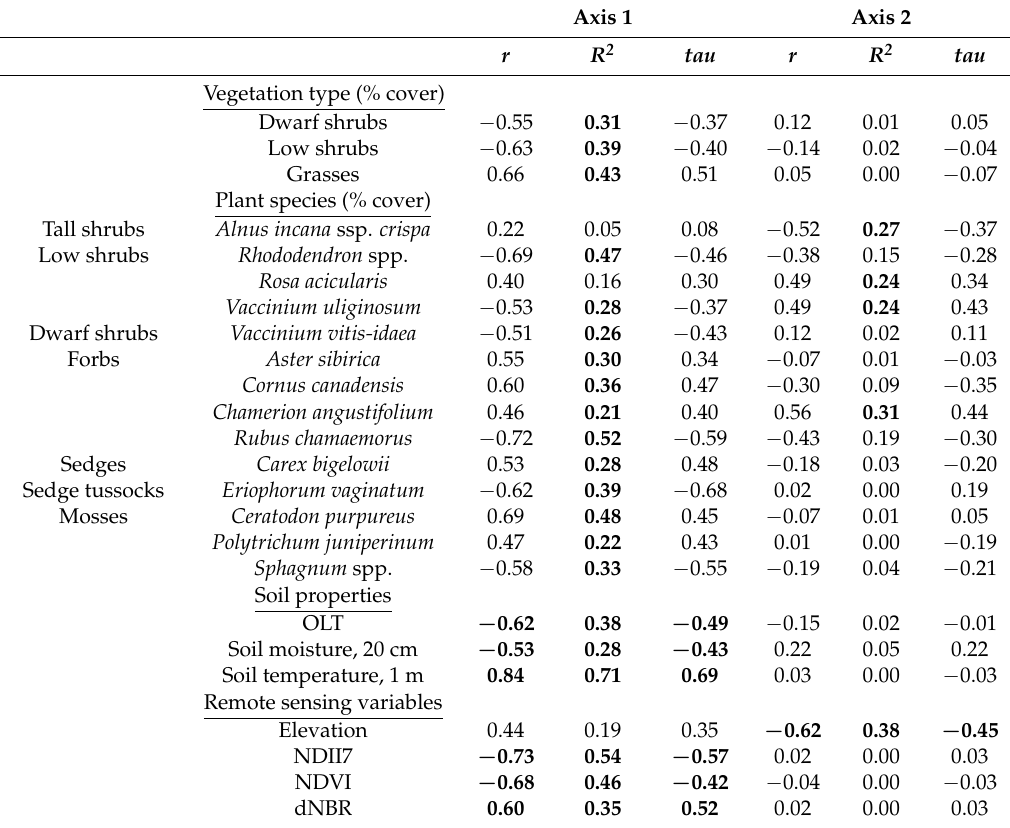
Table 4. Pearson and Kendall correlations of NMDS ordination axes with vegetation cover (by type and species), soil properties, and remote sensing metrics. Variables correlated with at least one axis with R 2 > 0.2 are shown with coefficients of determination are highlighted in bold. One outlier was excluded ( n = 29).